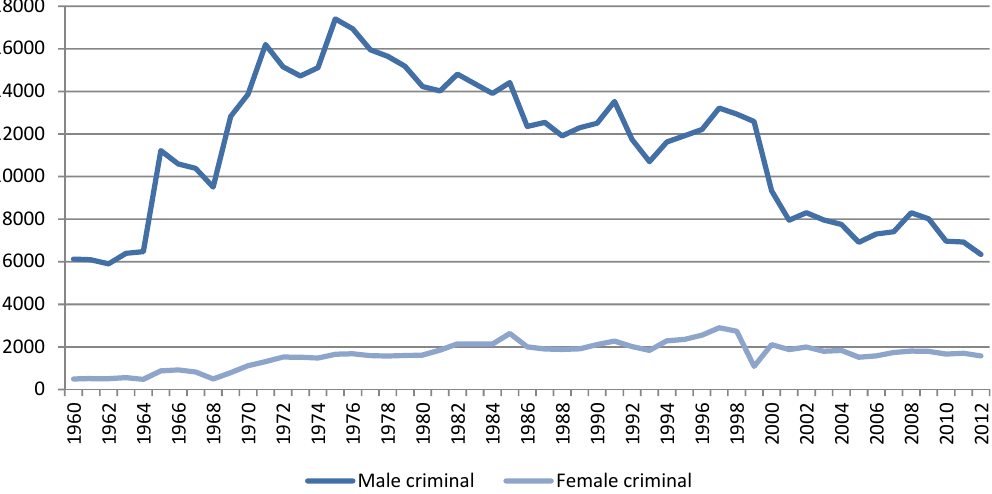
Figure 1: Finalised Court Appearances Criminal Offences, by Sex, NSW Children’s Courts 1960 ‐ 2012 Source: NSW Children’s Court Data (1960‐2012)